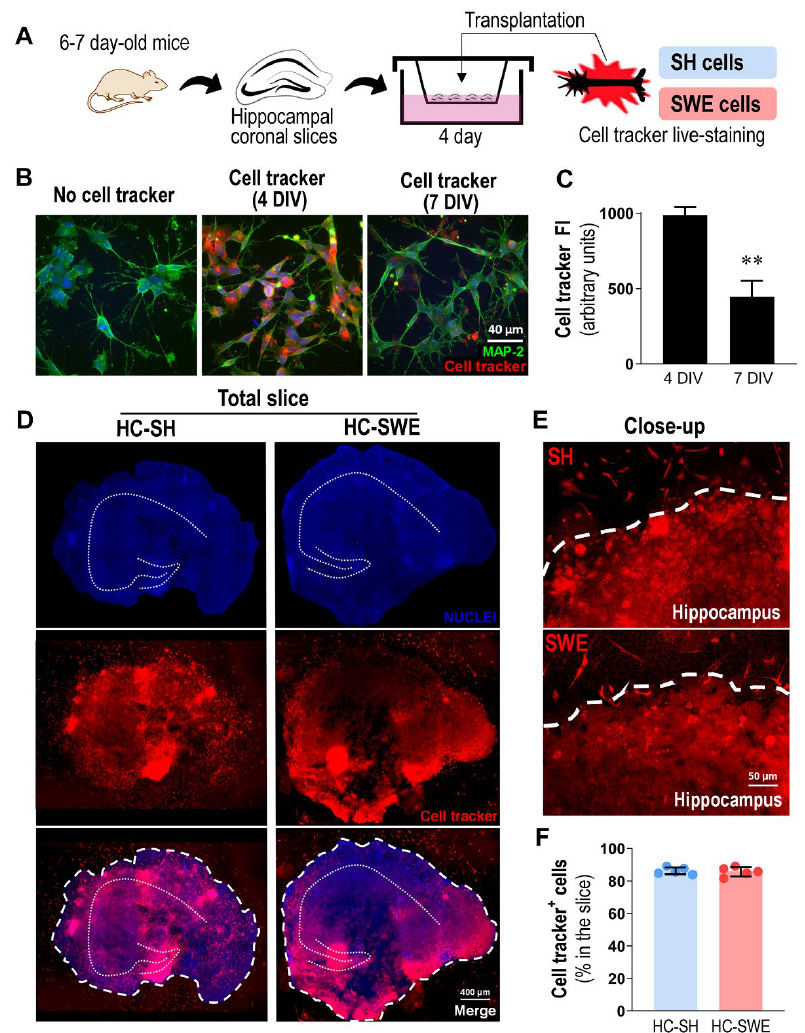
Figure 1. SH and SWE neuroblastoma cells were efficiently transplanted into mouse organotypic hippocampal coronal slices. ( A ) Schematic representation of the transplantation process after SH/SWE live-cell staining with cell tracker. ( B ) Representative fluorescence images showing cell tracker (red) after 4 and 7 days in vitro (DIV). Neuroblastoma cells were immunostained with MAP- 2, and nuclei were counterstained with Hoechst. ( C ) Cell tracker fluorescence quantification in SH/SWE after 4 and 7 DIV. ( D ) Representative fluorescence images of HC-SH or HC-SWE. Dotted lines represent a schematic outline of the hippocampal structure, and bold dashed lines delimit the margins of the organotypic hippocampal slices. Separate images are provided for nuclei and cell tracker, complemented with a merged image. ( E ) Representative close-up images for HC-SH and HC-SWE showing cell-tracker-positive SH or SWE cells inside and outside the margins of each hip- pocampal slice, with ( F ) respective quantification of cells grafted in the hippocampal slice. Scale bars correspond to 40 µm ( B ), 400 µm ( D ) and 50 µm ( E ). Results are mean ± SEM from five independent experiments. Two-tailed Student’s t -test: ** p < 0.01 vs. 4 DIV. SH, SH-SY5Y neuroblastoma cells; SWE, SH-SY5Y cells expressing human APP695 Swedish mutation; DIV, days in vitro; FI, fluores- cence intensity; HC-SH, hippocampal cultures with engrafted SH cells; HC-SWE, hippocampal cul- tures with engrafted SWE cells; MAP-2, microtubule-associated protein 2.